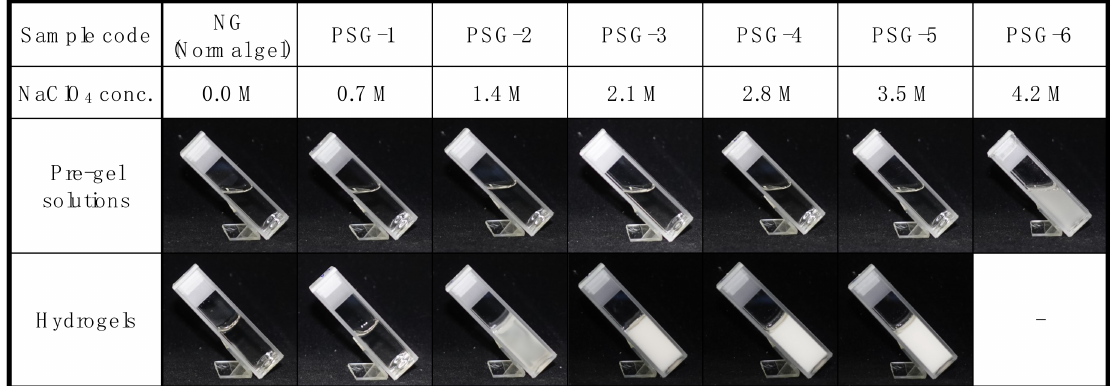
Figure 2. Photographs of pre-gel solutions and hydrogels in different conditions of polymerization.